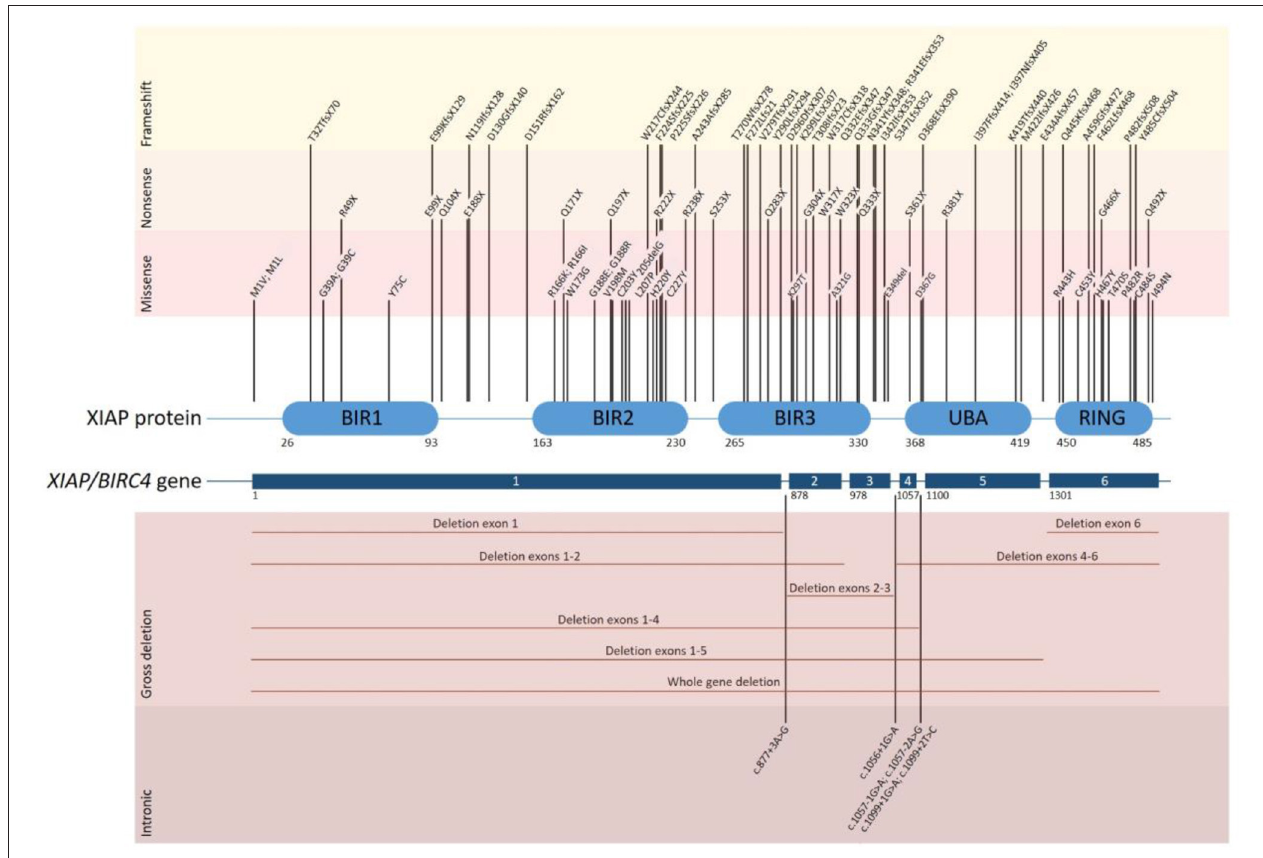
FIGURE 1 | Overview of all disease causing mutations in the XIAP/BIRC4 gene that have thus far been reported. The position of each of the reported mutations associated with XIAP deficiency is depicted along the XIAP protein and gene structure. Shown are the 6 coding exons that are present in the XIAP/BIRC4 gene and the 5 functional domains of the XIAP protein. Mutations are grouped by mutation type. Missense mutations cluster in the BIR2 and RING domain of the XIAP protein.